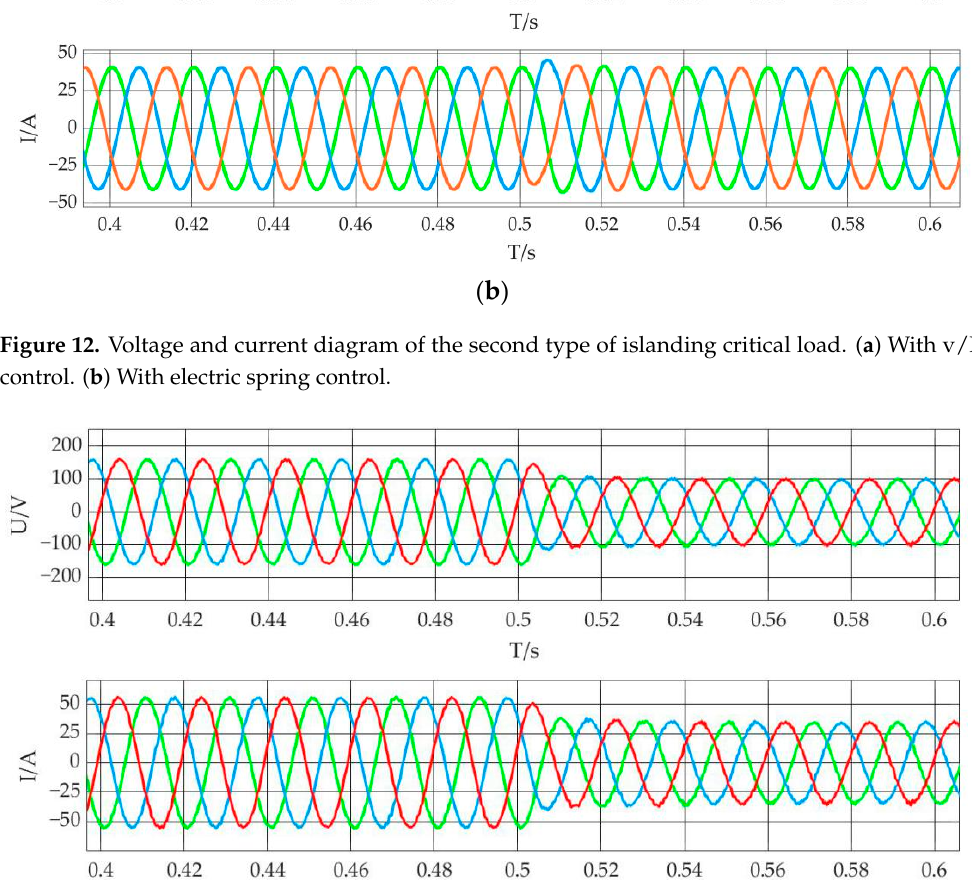
( b ) Figure 14. Critical load voltage curve. ( a ) With v/F control. ( b ) With electric spring control. According to Figures 9, 11, 12, and 14, when the voltage of critical load rises or falls abruptly due to an unplanned island of a microgrid, the electric spring can realize the voltage stabilizing control of key simulation and protect the critical load. 6. Conclusions In this paper, the electric spring was introduced into the voltage stabilizing control of critical load when an unplanned island occurs for the first time. The following findings are drawn from the analysis and design of power springs, as well as simulated analysis of several scenarios when an unplanned island develops in a microgrid: 1.